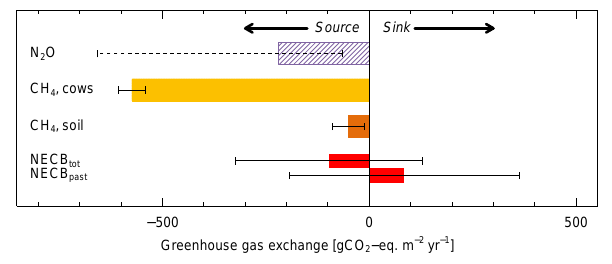
Figure 6. Comparison of greenhouse gas fluxes of the pasture sys- tem including cows during pasture use to the NECBs for the two system boundaries. The ecological sign convention is used: nega- tive values indicate a source from the system to the atmosphere. N 2 O emissions are modeled, whereas the other emissions are mea- surements. Detailed numbers can be found in Table